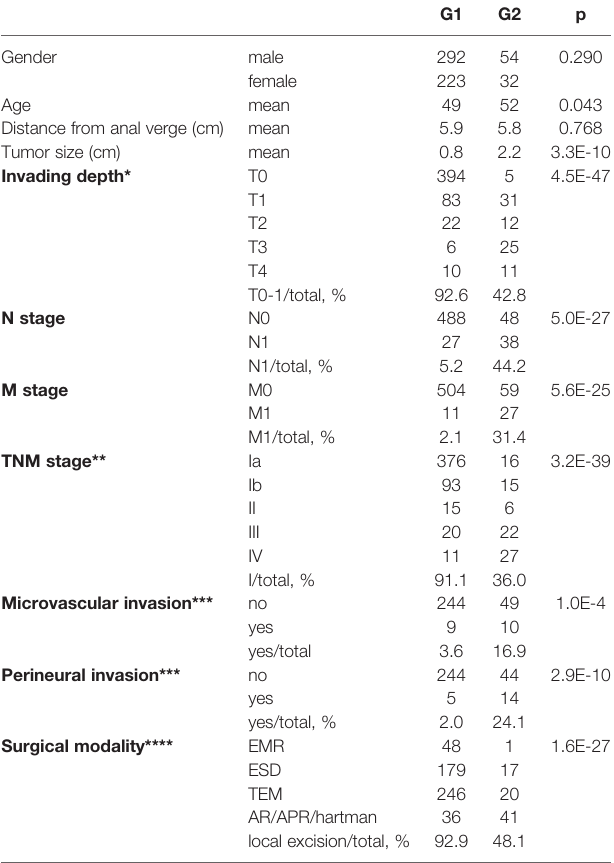
TABLE 2 | Comparison of rectal G1 NET with G2 tumor (n = 601).